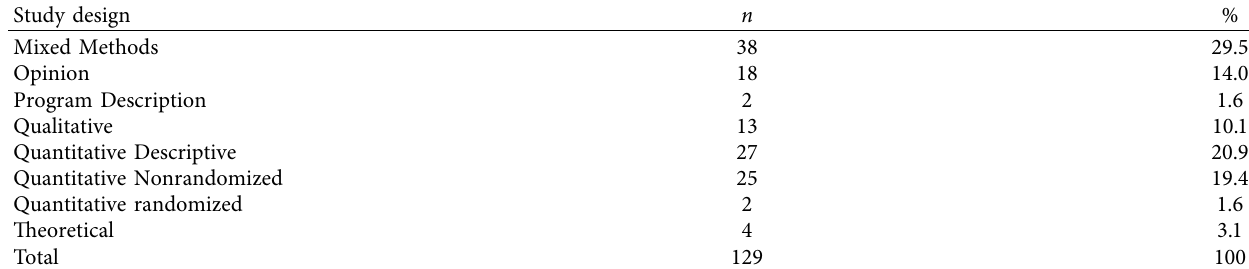
Table 5: Study characteristics: study design.